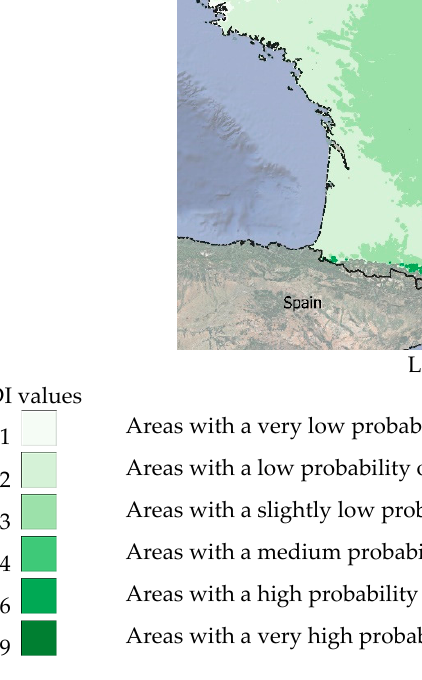
Figure 6. Maps of BDI estimated for 2050 related to Fagus sylvatica L. (beech), Populus nigra L. (Italian poplar), Abies alba Mill. (Silver fir), Picea excelsa (Lam.) Lk. (spruce), and Pinus silvestris L. (Scots pine).